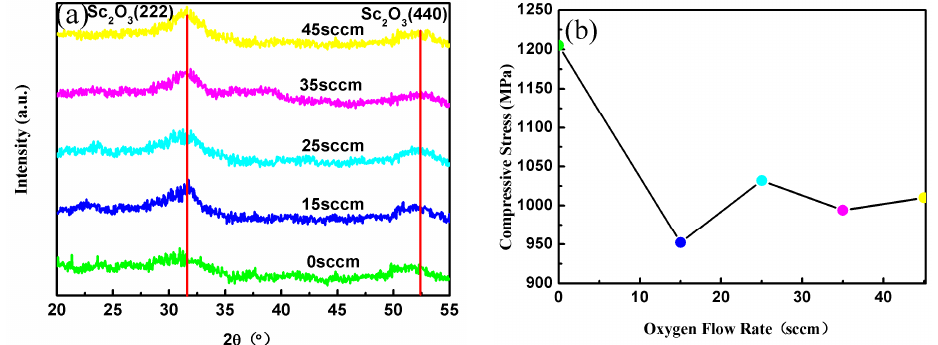
Figure 3. ( a ) X-ray diffraction spectra of Sc 2 O 3 films deposited under different oxygen flow rates; ( b ) Compressive stress in Sc 2 O 3 films under different oxygen flow rates.